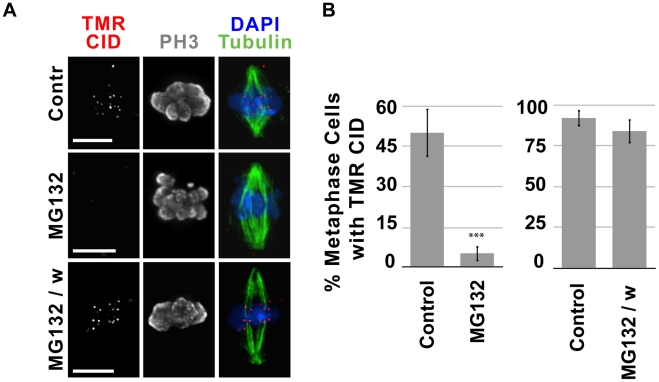
MG132 inhibition of the 26S proteasome suppresses recruitment of new CID.A) Representative images of untreated cells (Contr), cells treated with MG132 before and after BTP-block (MG132) and treated with MG132 prior to BTP block and washed with normal serum medium during chase (MG132/w). MG132 treatment blocked new CID loading, but this was reversible since removal of the drug by washing cells restores new CID loading. Tubulin is shown in green, phospho H3 in gray, TMR in red and DAPI in blue. Bar = 5 µm. B) In independent experiments, untreated cells (control, n = 29), cells treated with MG132 (n = 37; left panel) and untreated cells (control, n = 27) and MG132 treated cells followed by a chase without MG132 (n = 25; right panel) were scored for the presence or absence of centromeric TMR-labeled CID. The percent of cells (y-axis) with visible centromeric new SNAP-CID decreased dramatically in the presence of MG132 (p<0.0001, Fisher's exact test).